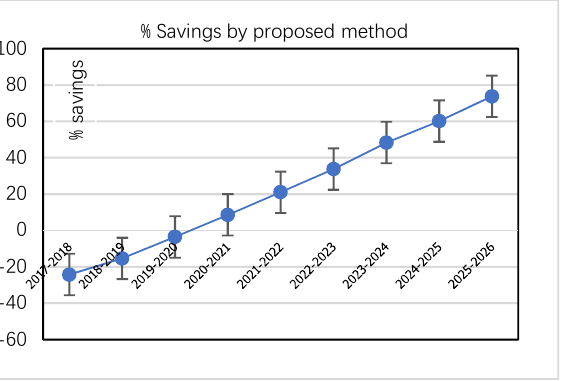
Figure 11. Percentage savings of proposed hybrid system for residential “from year 2017/2018 to year 2026/2027 ” .